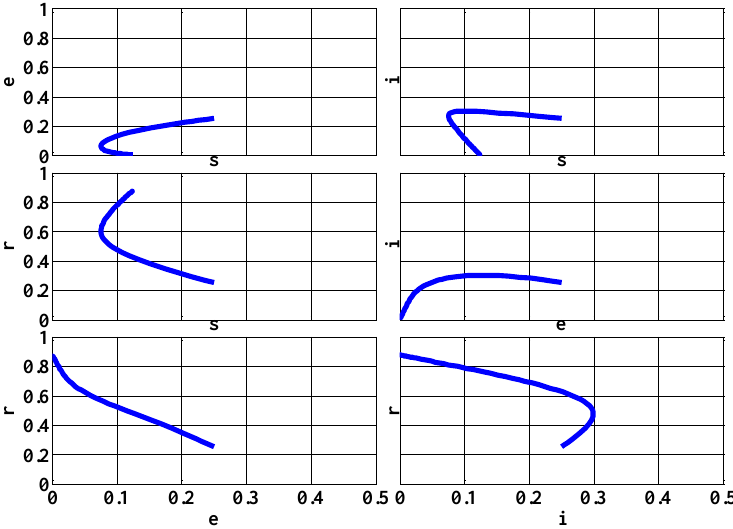
Figure 3. Phase Portraits with Initial Conditions ( s (0), e (0), i (0), r (0)) = (0.25, 0.25, 0.25, 0.25) (β = ¼ (No Epidemic)).